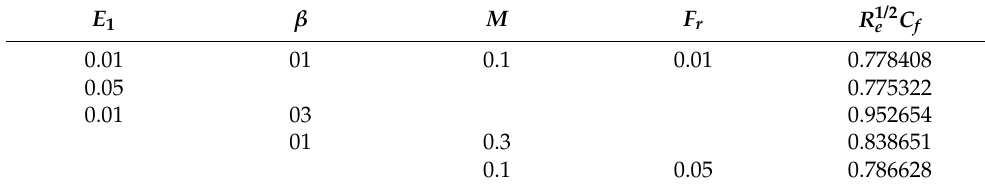
Table 2. List the numerical values of R 1/2 e C f using λ = 0.1 and N ( no . of grid points ) = 30.